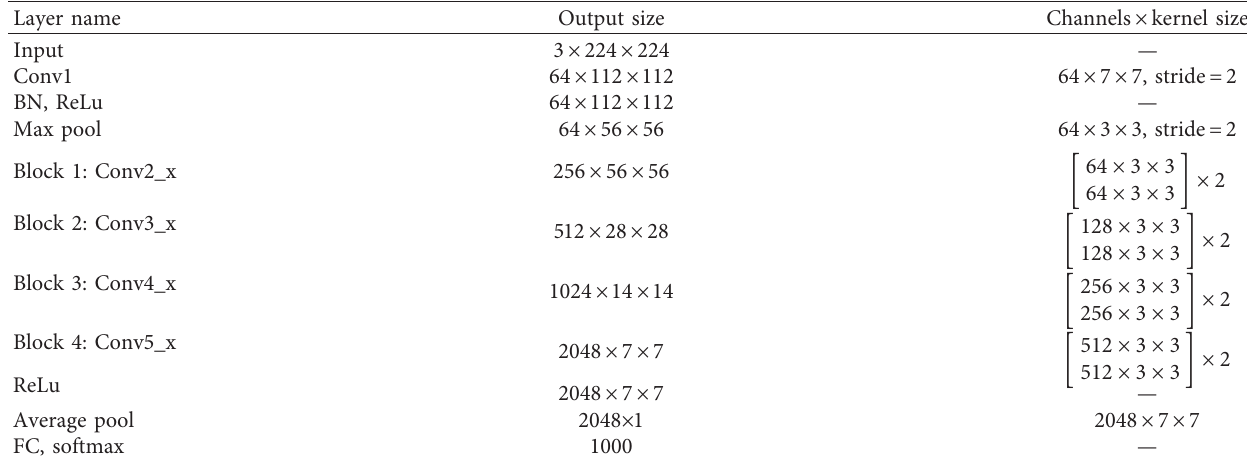
Figure 1: An illustration of the DA branches in a fault diagnosis tree. Table 1: Detailed information of the ResNet-18